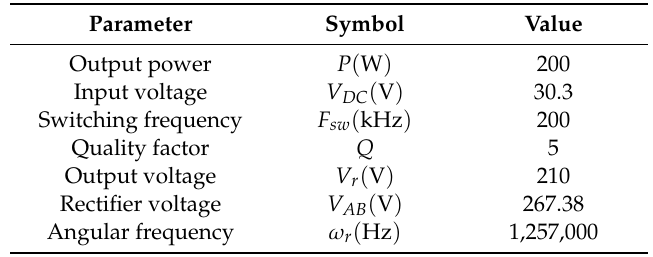
Table 2. Design parameters.